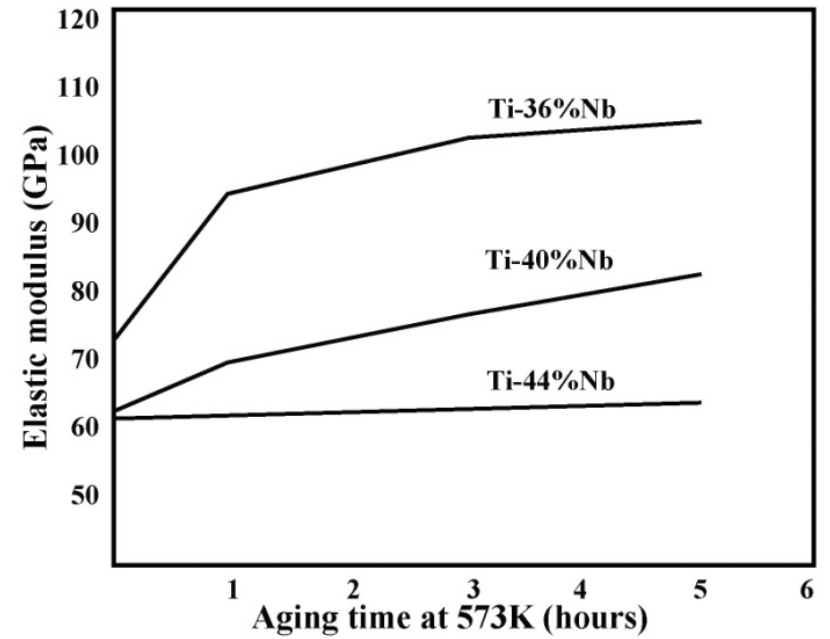
Figure 8. Aging time dependence of Young’s modulus of Ti-36, 40%, and 44% Nb binary alloys at 573 K ([92], modified). Reprinted with permission from [92]. Copyright 2005 ASM international (for individual